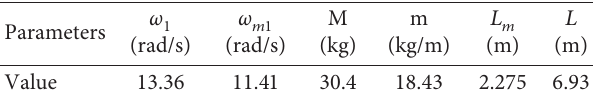
Table 1: Parameter table of equivalent length calculation.